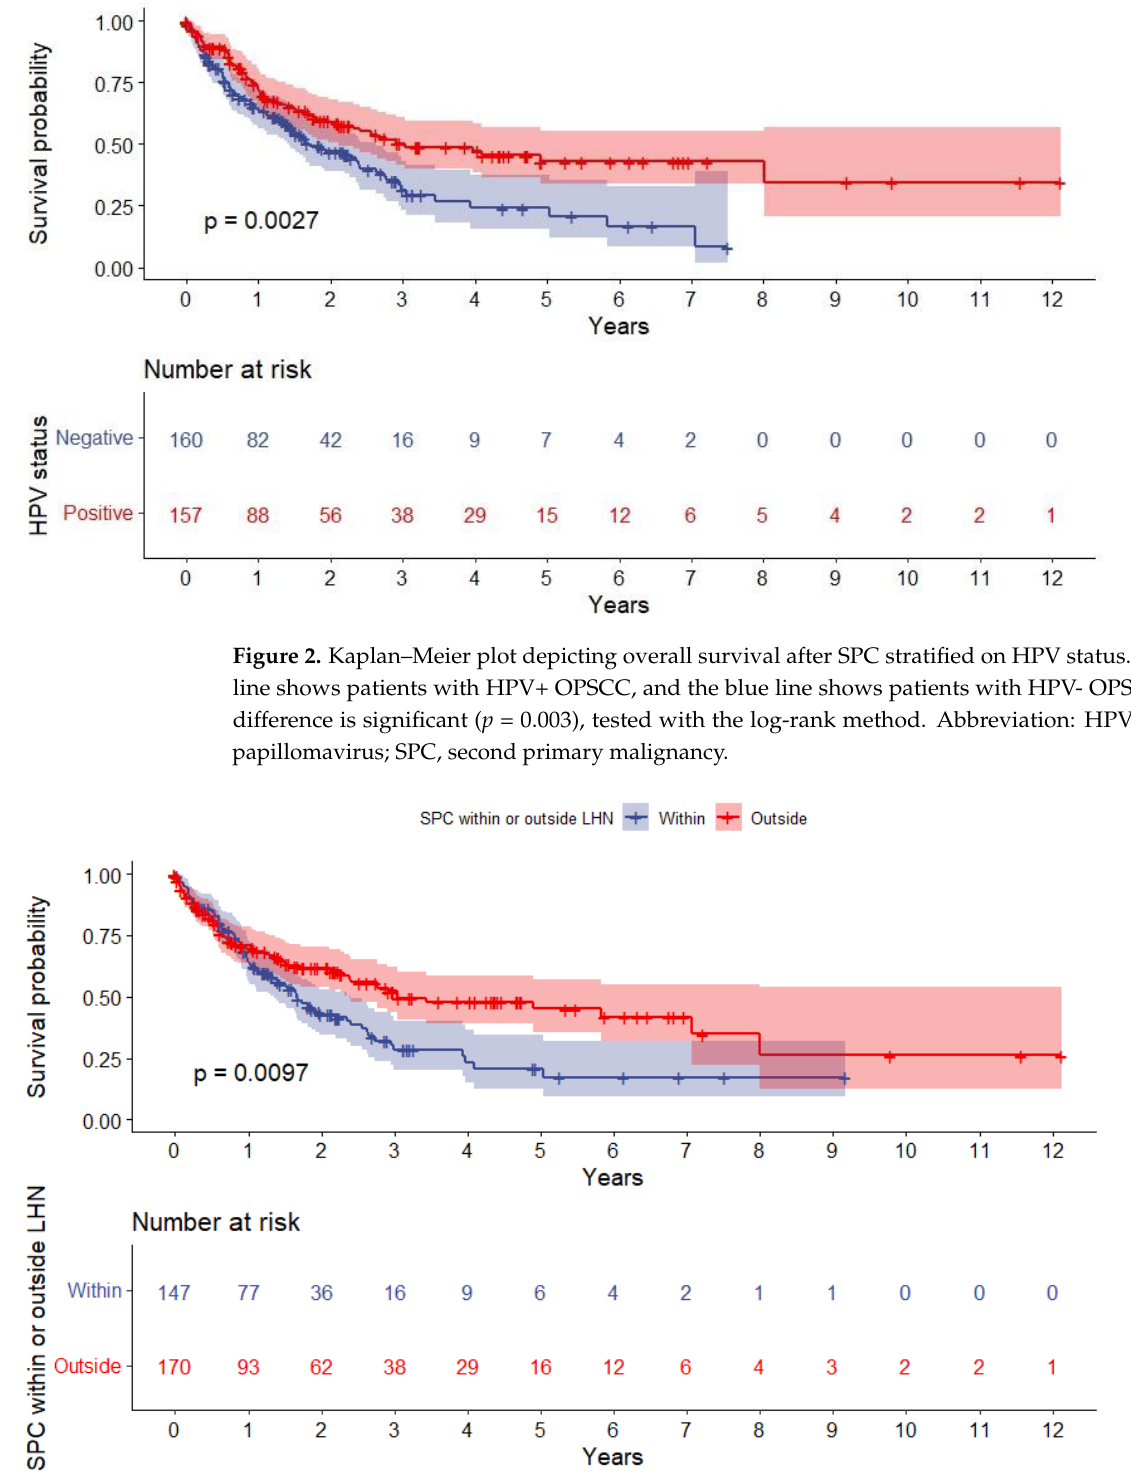
Figure 3. Kaplan – Meier plot depicting overall survival after SPC stratified by SPC localized within or outside the LHN. The red line shows patients with SPC outside LHN, and the blue line shows patients with SPC within LHN. The difference is significant ( p = 0.01) tested with the log-rank method. Abbreviation: SPC, second primary malignancy; LHN, lungs, head, and neck.